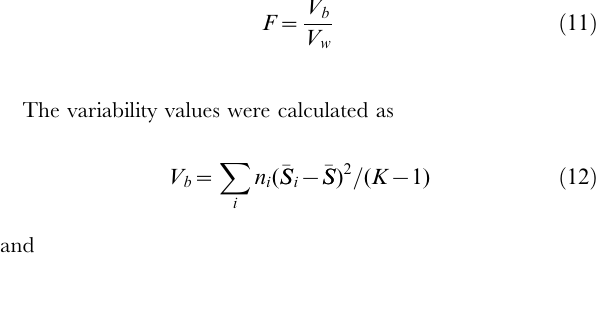
Figure S1 Wild-type Escherichia coli data collected at different dilution rates (Ishii et al., Science, 2007): gene expression data (triangles; A ), flux data (circles; B ), principal component analysis (PCA) using gene expres- sion data (triangles; C ), and flux data (circles; D). Gene expression data were normalized to range from 0 to 1. Flux data were scaled so that the glucose uptake flux is 100 mmol/(gDW ? h). For the PCA, both gene expression and flux data were normalized by their maximal value to range from 0 to 1. D denotes dilution rate [1/h]. Table S1 Sum of squared error (SSE) of E-Fmin and other methods in predicting intracellular flux distribu- tions in Saccharomyces cerevisiae at different glucose uptake rates, wild-type Escherichia coli at varied dilution rates, and mutated E. coli with single gene knockouts. Table S2 Comparison of exchange fluxes of Saccharo- myces cerevisiae between experimental data and com- putational predictions. Table S3 Comparison of intracellular fluxes of